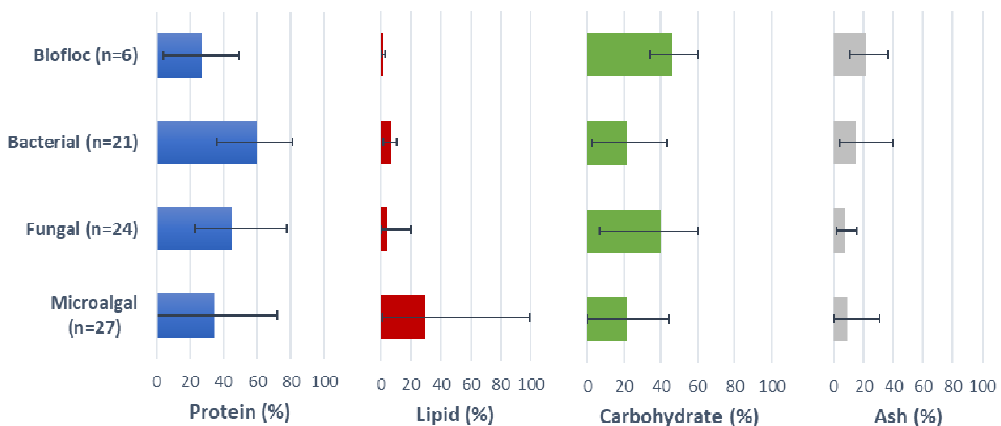
Figure 1. Summary of the proximate composition (% dry basis) of the range of microalgal, fungal, bacterial and biofloc resources reported as feed ingredients in aquaculture. Shown are the number of different products characterised, the mean composition parameters in each group as well as the upper and lower ranges.